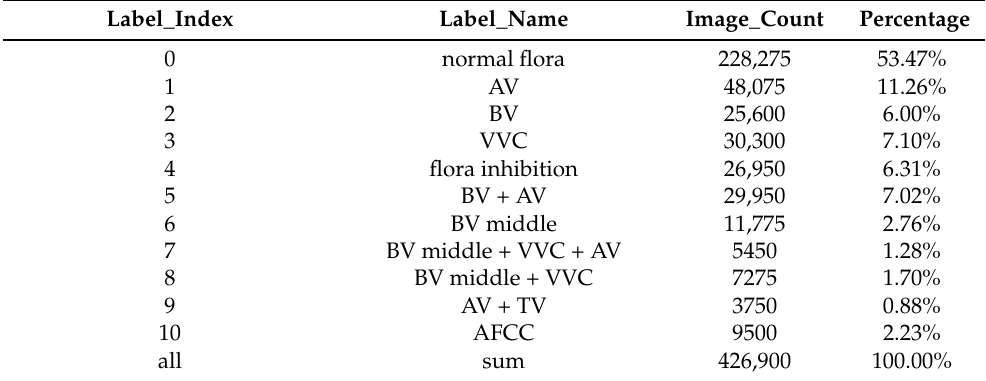
Table 3. The primary